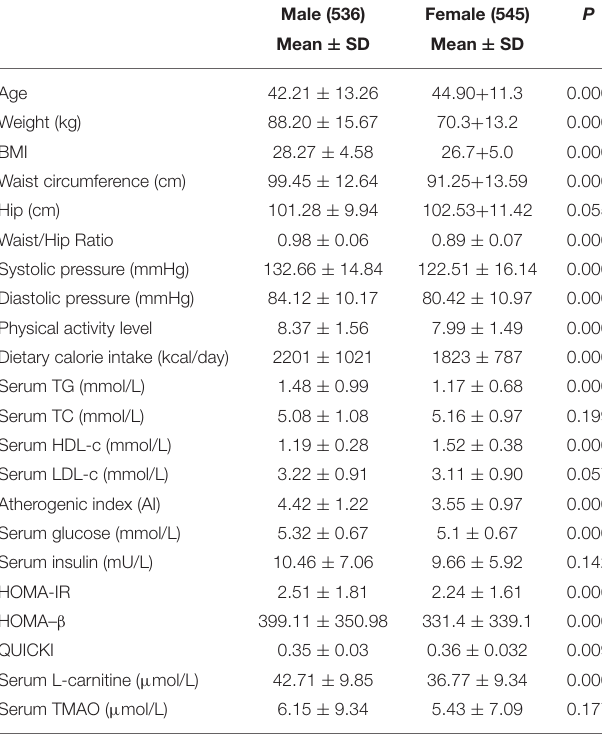
TABLE 1 | Characteristics of the participants by